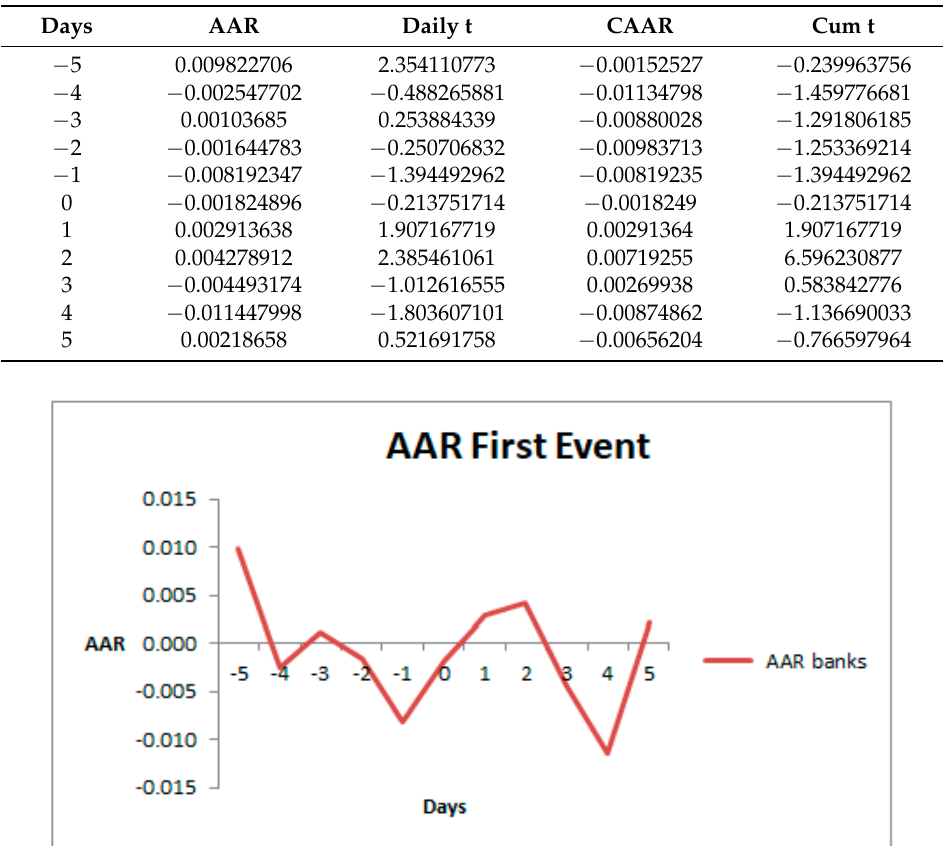
Figure 4. Average Abnormal Return (AAR) for banks. Source: Authors’ work.